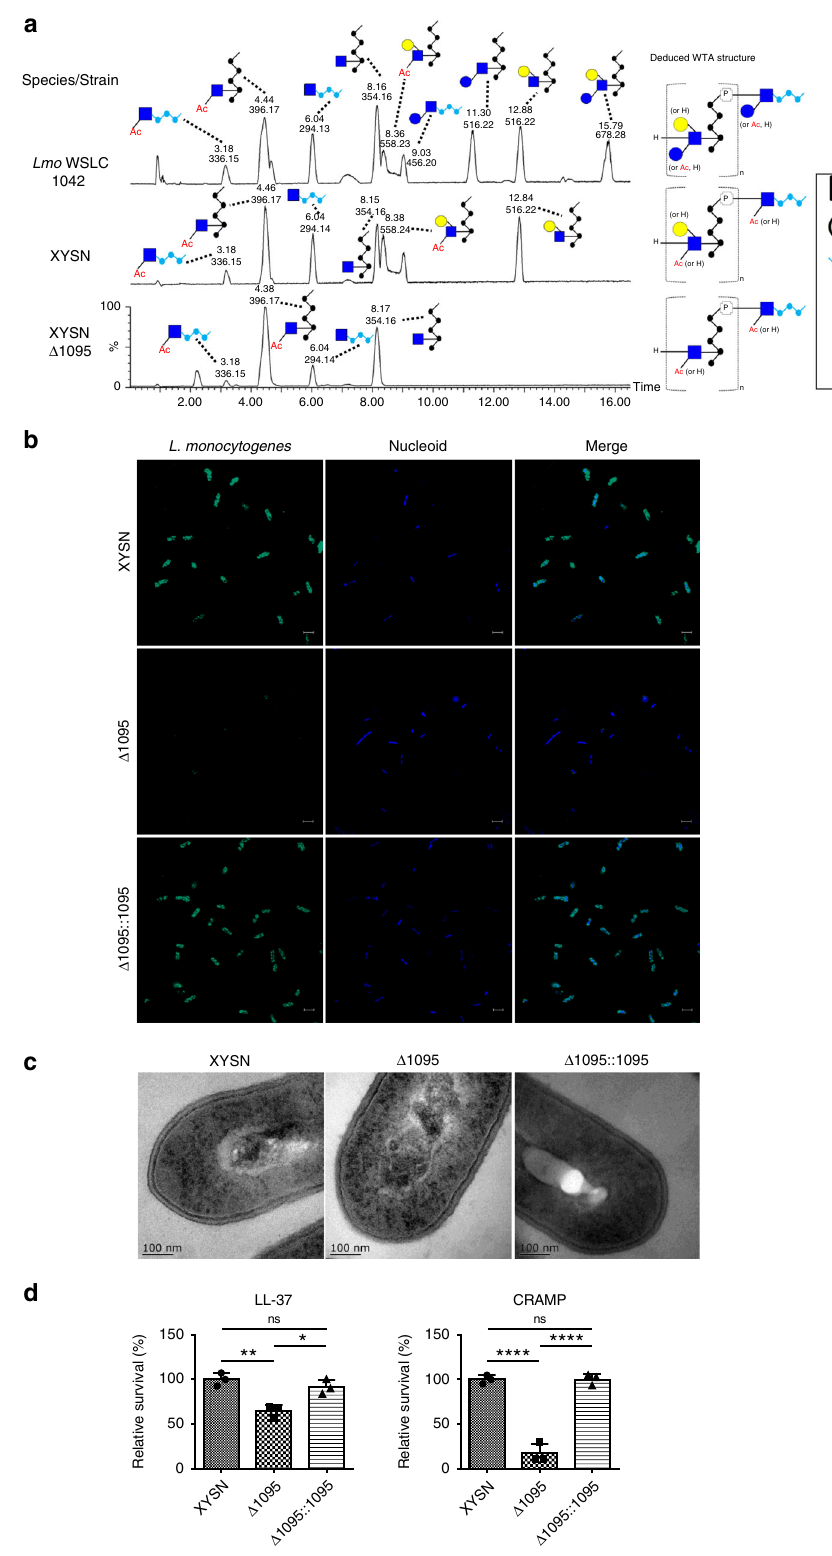
Role of listeriolysin and sphingomyelinase in the virulence of XYSN . As XYSN exhibits a strong invasive phenotype, we used the epithelial cell line Caco-2 BBe to assess the relative con- tributions of hly and smcL to invasion. Loss of the hly gene reduces the invasive ability of XYSN sevenfold and underlines a role of listeriolysin in promoting bacterial entry. For the mutant